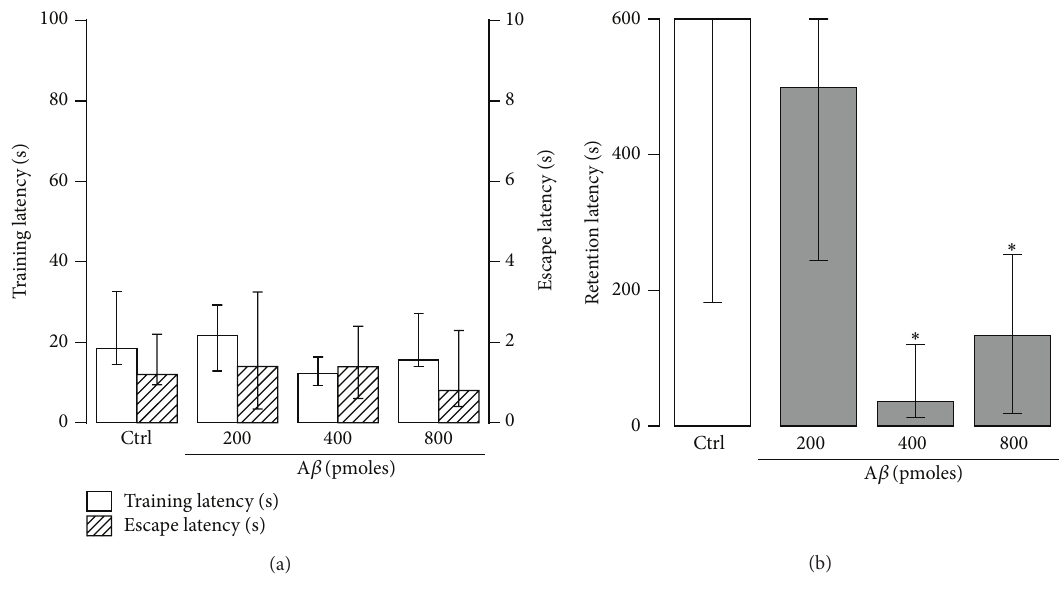
Figure 2: A 𝛽 induces contextual memory deficits. (a) Training and escape latencies of groups injected into the hippocampus with MF12 (Ctrl) or A 𝛽 (200, 400, and 800 pmoles) and then evaluated in the inhibitory avoidance task. There were no significant differences among the groups in either latency. (b) Retention latencies of Ctrl and A 𝛽 groups measured 48h after training ( 𝑛 = 6–11 rats/group). Data are presented as medians ± interquartile ranges. ∗ 𝑝 < 0.05 versus Ctrl.